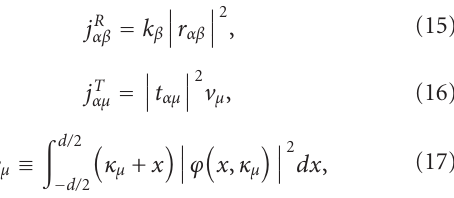
Figure 14: A contour plot of an electron density in a sample dot for √ 20 π , (cid:4) B = 4, and the fundamental mode Kd =